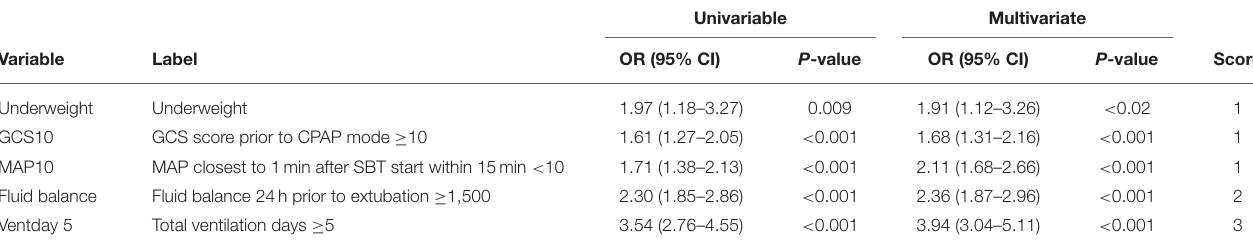
TABLE 3 | Logistic regression model predicting extubation failure.